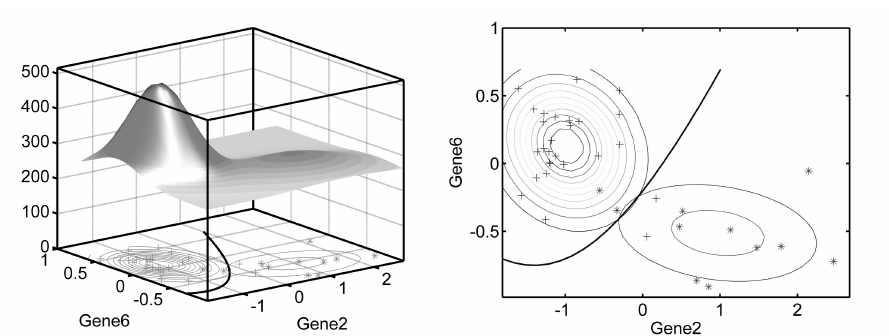
Figure 4. Estimated classifier for quadratic discrimination QDF; apparent error = 0.105, CV = 0.1 (SD = 0.01)